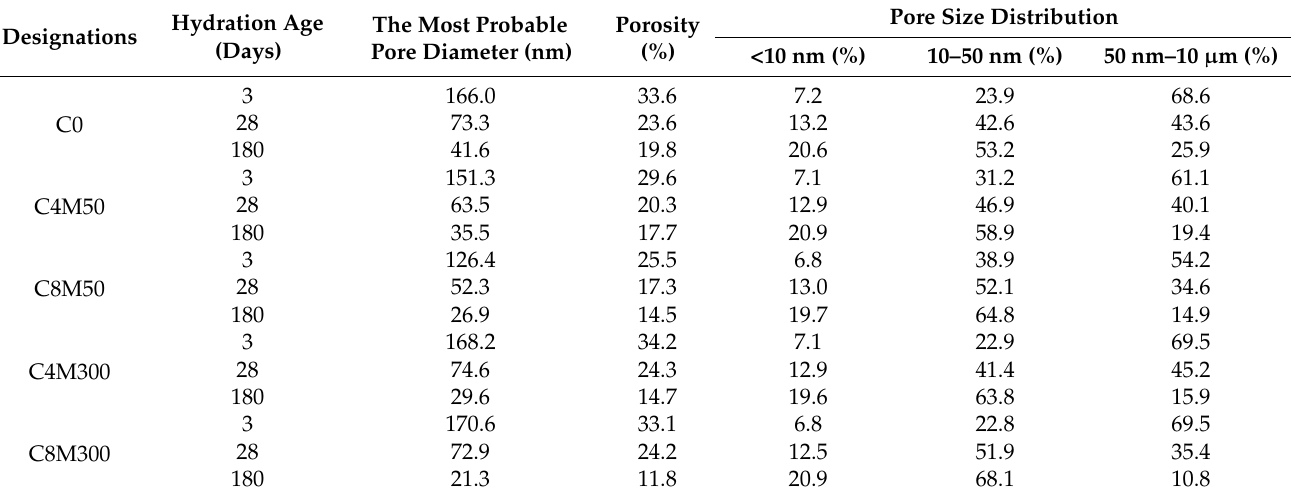
Table 4. Pore structure parameters of concrete obtained by